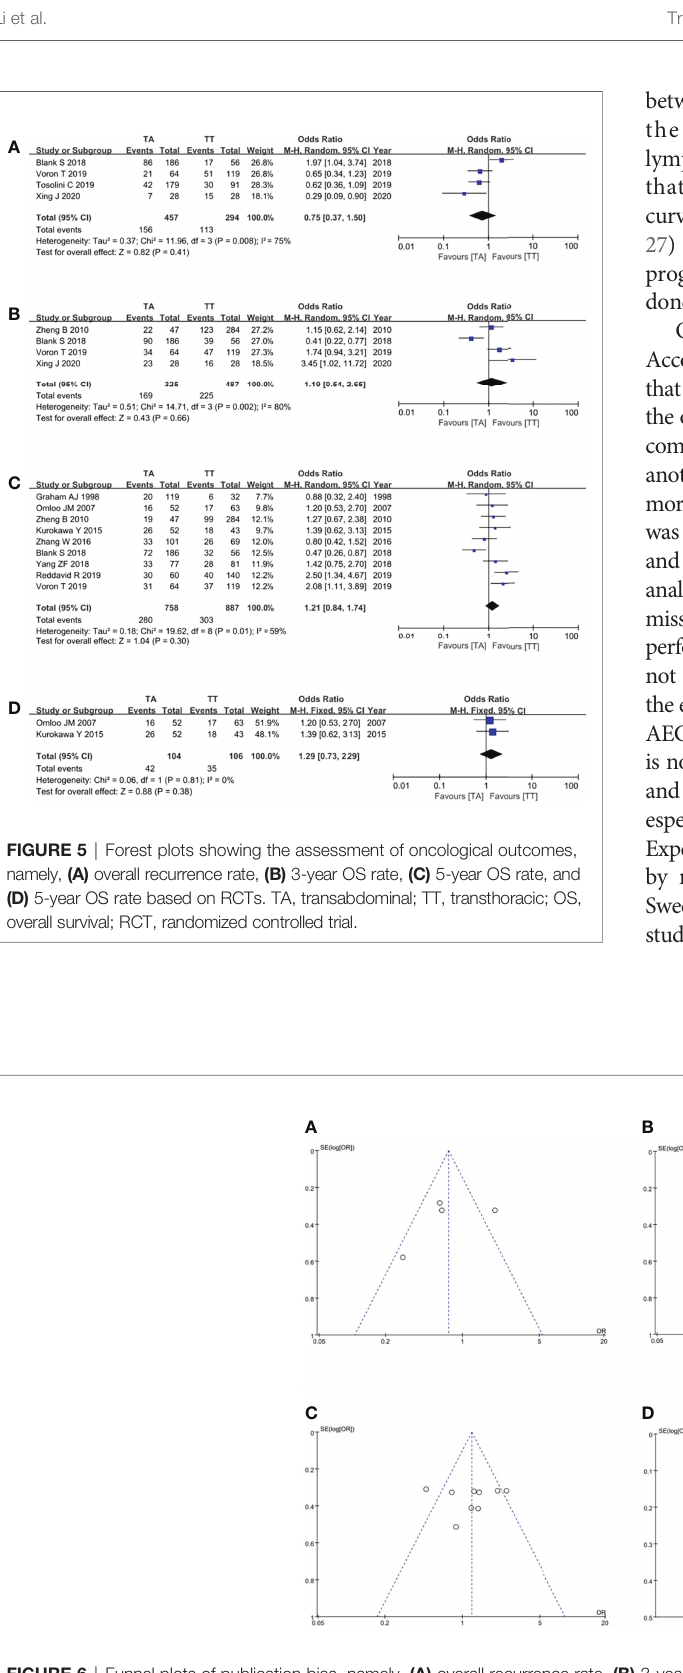
FIGURE 6 | Funnel plots of publication bias, namely, (A) overall recurrence rate, (B) 3-year OS rate, (C) 5-year OS rate, and (D) 5-year OS rate based on RCTs. RCT, randomized controlled